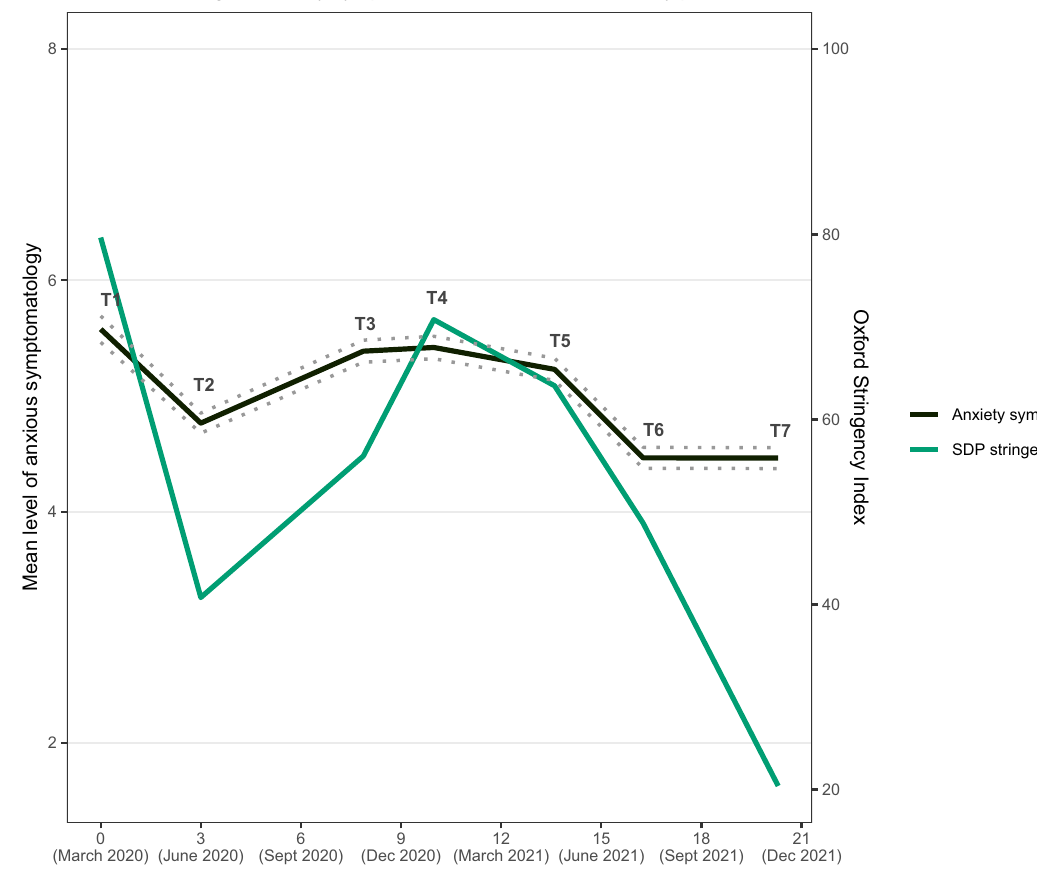
Figure 1. The mean-level profile of anxiety and the strictness of social distancing protocols (SDPs) over the 20-month observation period. Anxiety change patterns were modelled upon all modifications in national SDPs over the pandemic period. The dashed lines represent the 95% confidence intervals. Each month is coded in units of 30 days ensuing the starting point March 31, 2020, coded as